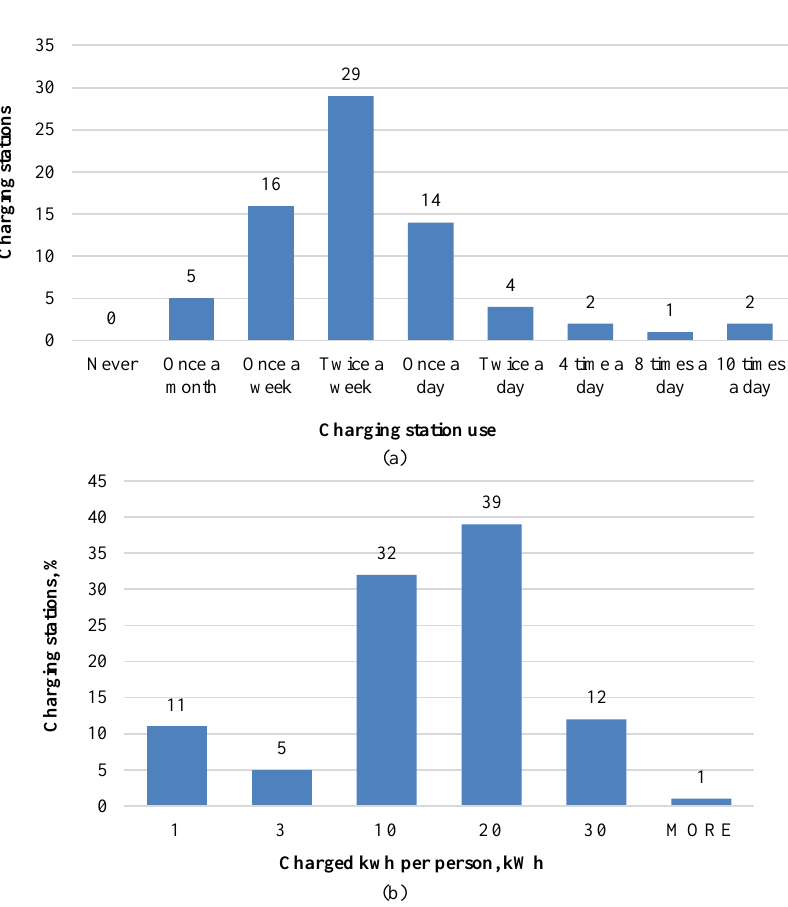
Fig. 1. (a) National fast charging network utilization in Latvia during first six months of operation in 2018; (b) charged amounts in charging sessions during first six months of operation in 2018. This was quite different from the results reported in Ireland [13], where the largest segment of the charging of the vehicles was 4–6 kWh, representing 19 % of all events. The fast charging in Ireland also demonstrated 8.32 kWh per average charging session. The average charging session data in Amsterdam was very similar – 8.31 kWh [11], which might be explained by higher PHEV proportion in the electric transport fleet and thus higher AC charging